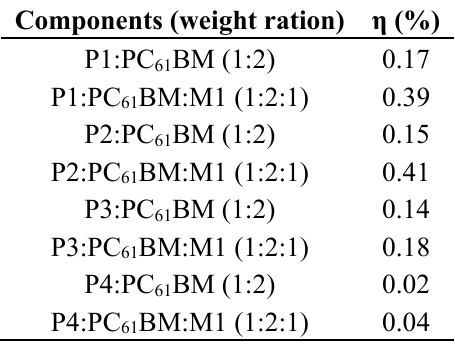
Figure 2. AFM image of active layer of solar cells with the configuration P2:PC 61 BM:M1 (1:2:1 by weight). Table 2. Power conversion efficiency parameters for different organic photovoltaics (OPVs) based on polythiophene derivatives P1–P4 under illumination at 100 mW/cm 2